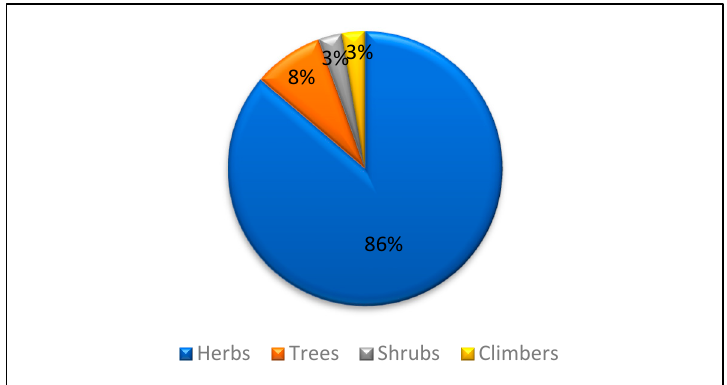
Figure 3. Species contribution of plants according to life form.